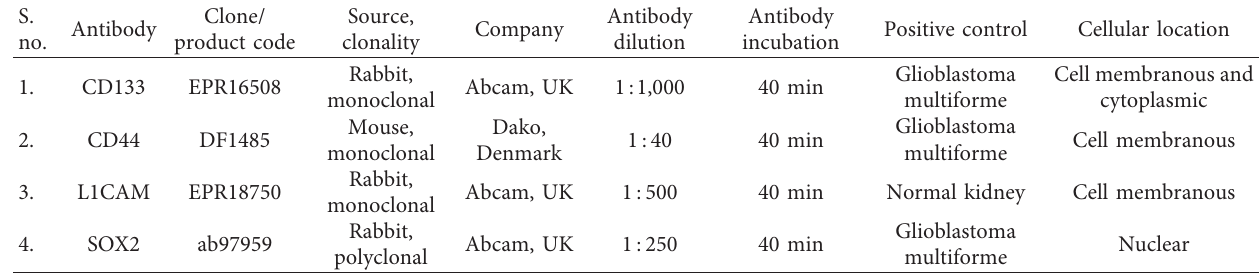
Table 1: IHC protocol and antibody